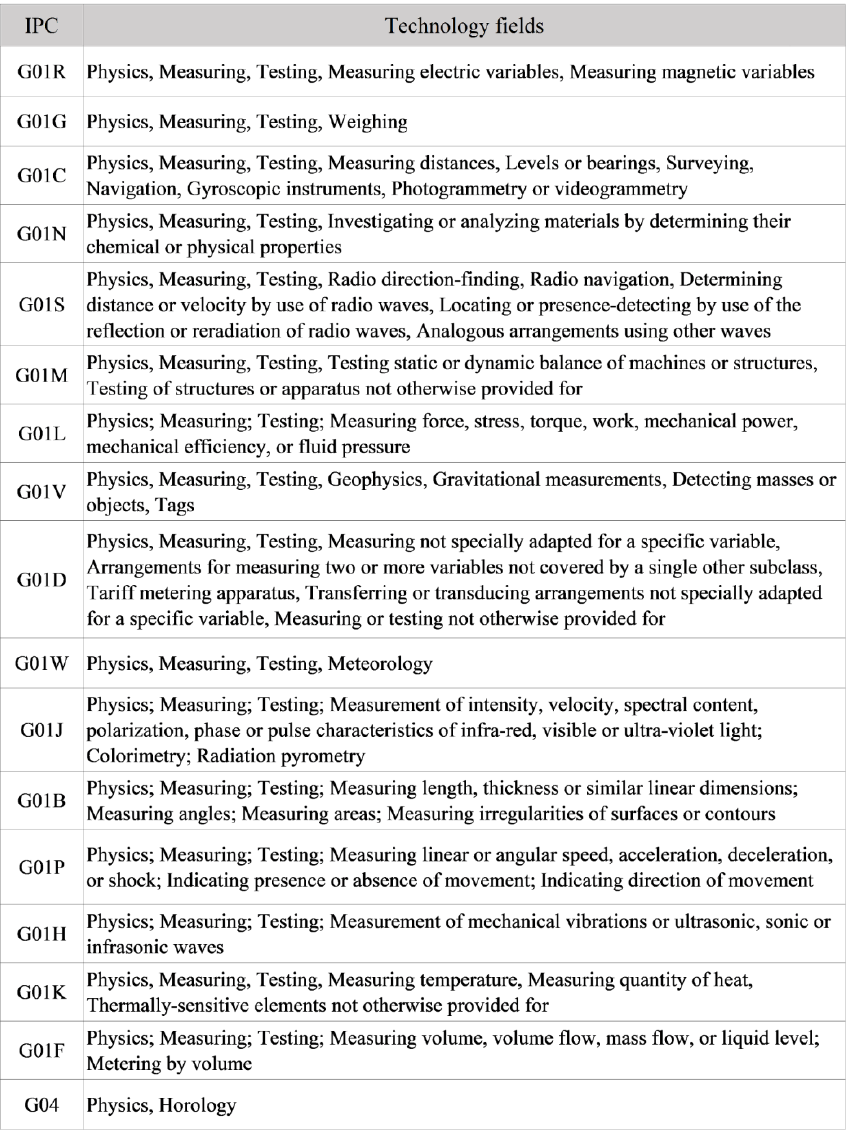
Fig. 9 Definitions of IPC numbers in